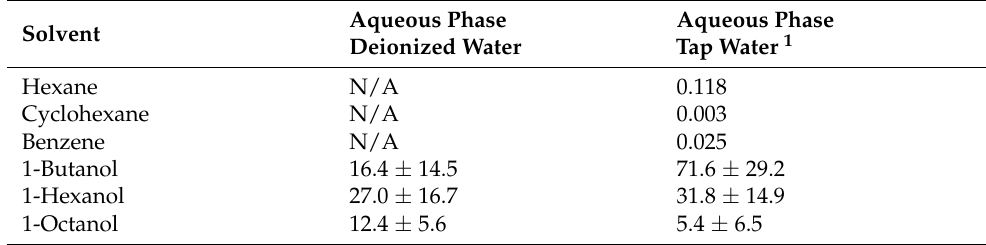
Table 2. Summary of partition coefficients for PFOA in selected